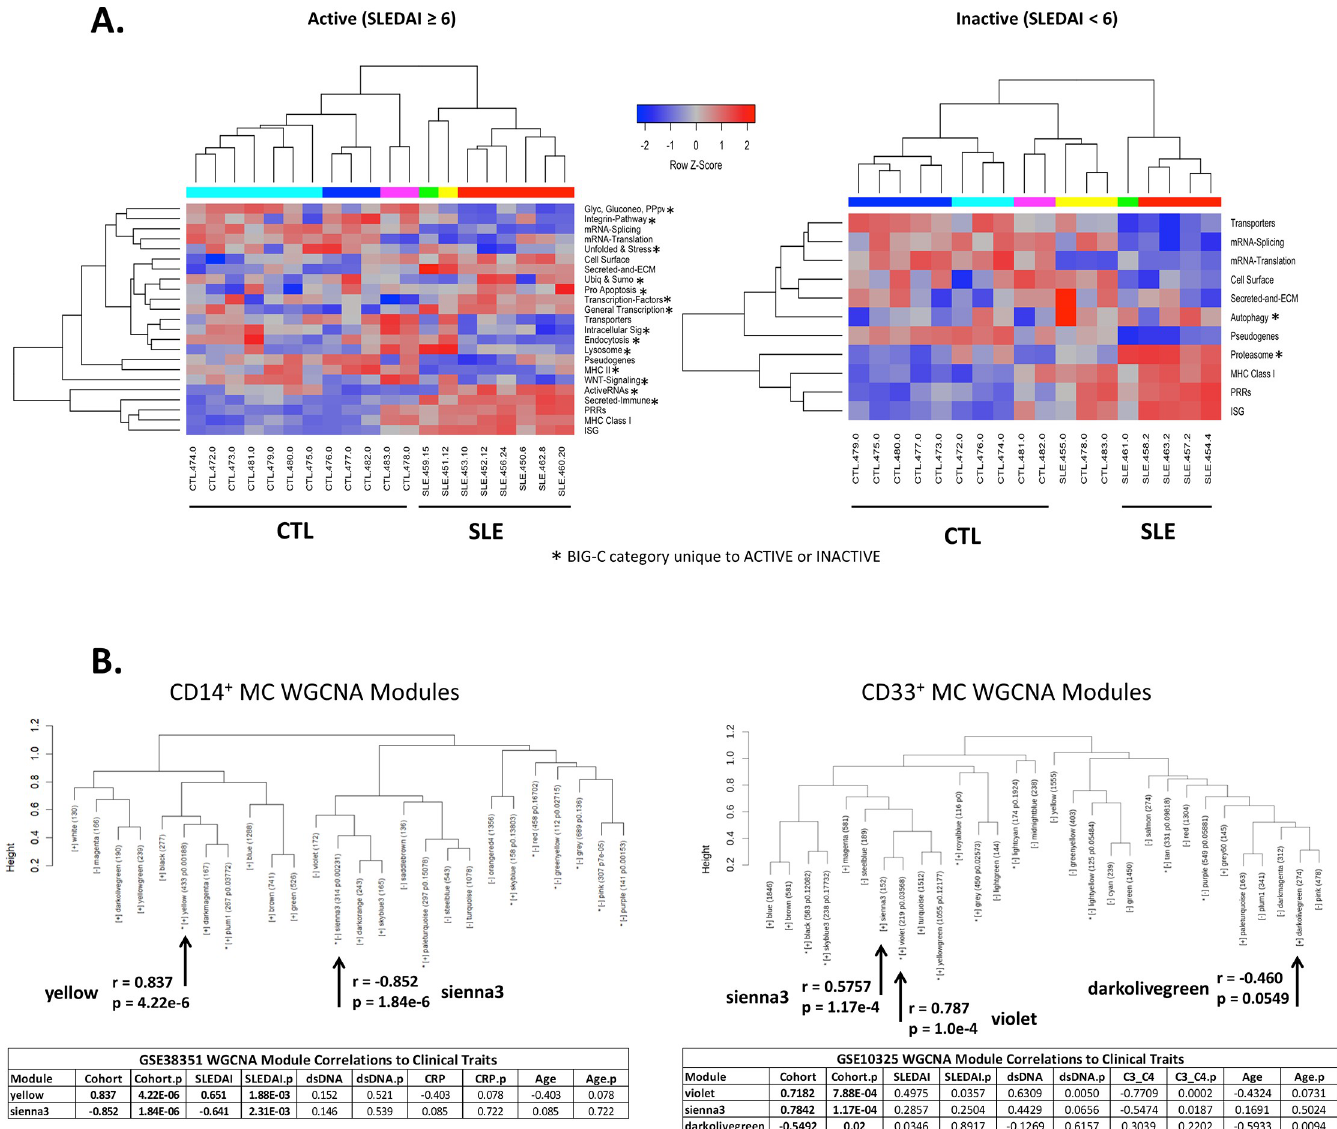
Fig 2. Clustering and module formation of DE gene signatures in CD14 + and CD33 + MC isolated from SLE Patients. (A) DE genes from active and inactive CD14 + MC were analyzed by GSVA to determine pathway enrichment using functional definitions provided from the BIG-C (Biologically Informed Gene Clustering) annotation library. Samples were successfully sorted by disease cohort via this method in both active and inactive MC. Starred BIG-C categories only appeared in the active or inactive analysis, respectively. (B) WGCNA of CD14 + and CD33 + MC isolated from SLE patients. Dendrograms show hierarchy of modules formed by unsupervised WGCNA clustering of DE genes from CD14 + and CD33 + MC isolated from active and inactive SLE patients.